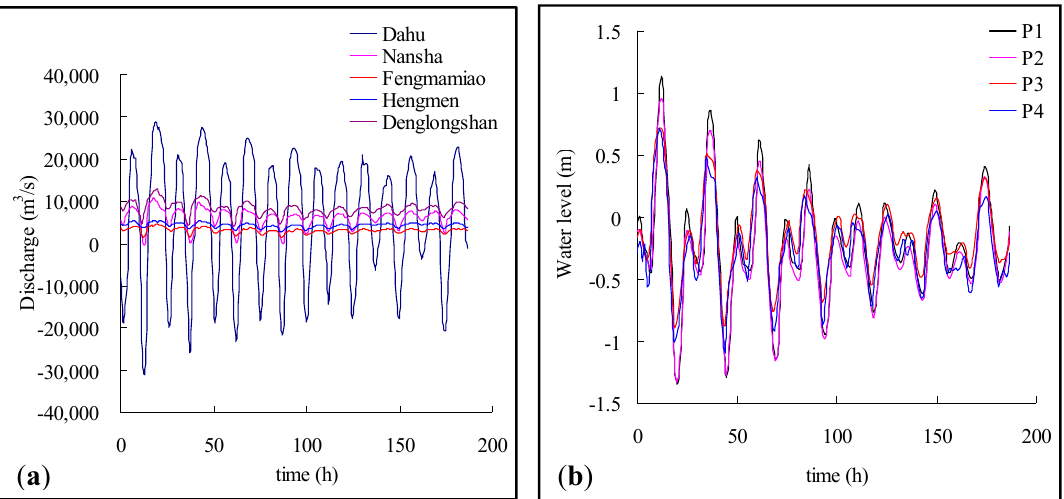
Figure 6. Sandbar simulation: the boundary conditions of the tidal currents model. ( a ) discharge (>0: ebb tidal; <0: flood tidal);( b ) tidal level.